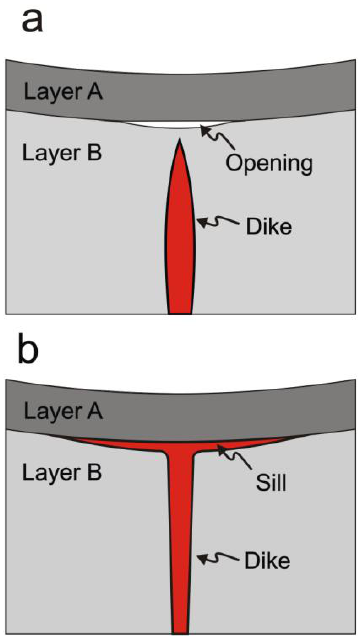
Fig. 5. (a) Schematic presentation of boundary element-model re- sults showing opening, debonding or delamination, of a weaker contact between stiffer layers ahead of an overpressured (10MPa) propagating dike. (b) If the dike reaches the contact, it may either become deflected into a sill (Figs. 7 and 10), as indicated here, or become arrested (Figs. 8 and 10).